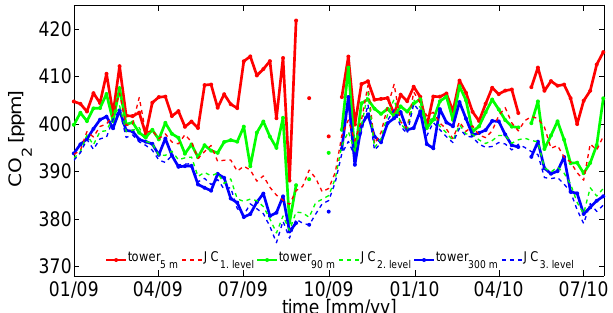
Fig. 9. The Jena CO 2 inversion at levels corresponding to the tall tower levels in comparison with the tall tower data (5m, 90m, 300m). Weekly averages of nighttime measurements between 00:00a . m . and 05:00a . m . are compared. The model captures the seasonal cycle at the upper level, but fails to simulate the nighttime CO 2 accumulation seen especially in summer at 5m and 90m.